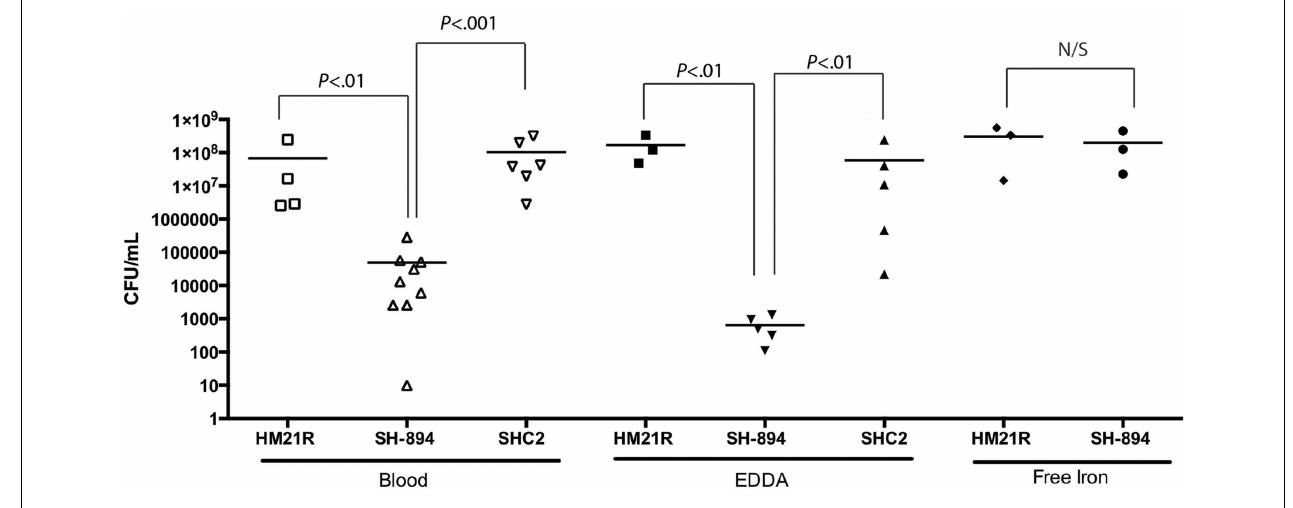
the blood meal the colonization defect of the double mutant was restored, further linking the inability to obtain iron within the leech crop. Each symbol represents the colonization level in one leech. The statistically significant difference between the parent strain and each mutant was performed using a Mann–Whitney test. Bonferroni corrections were preformed and the critical threshold is